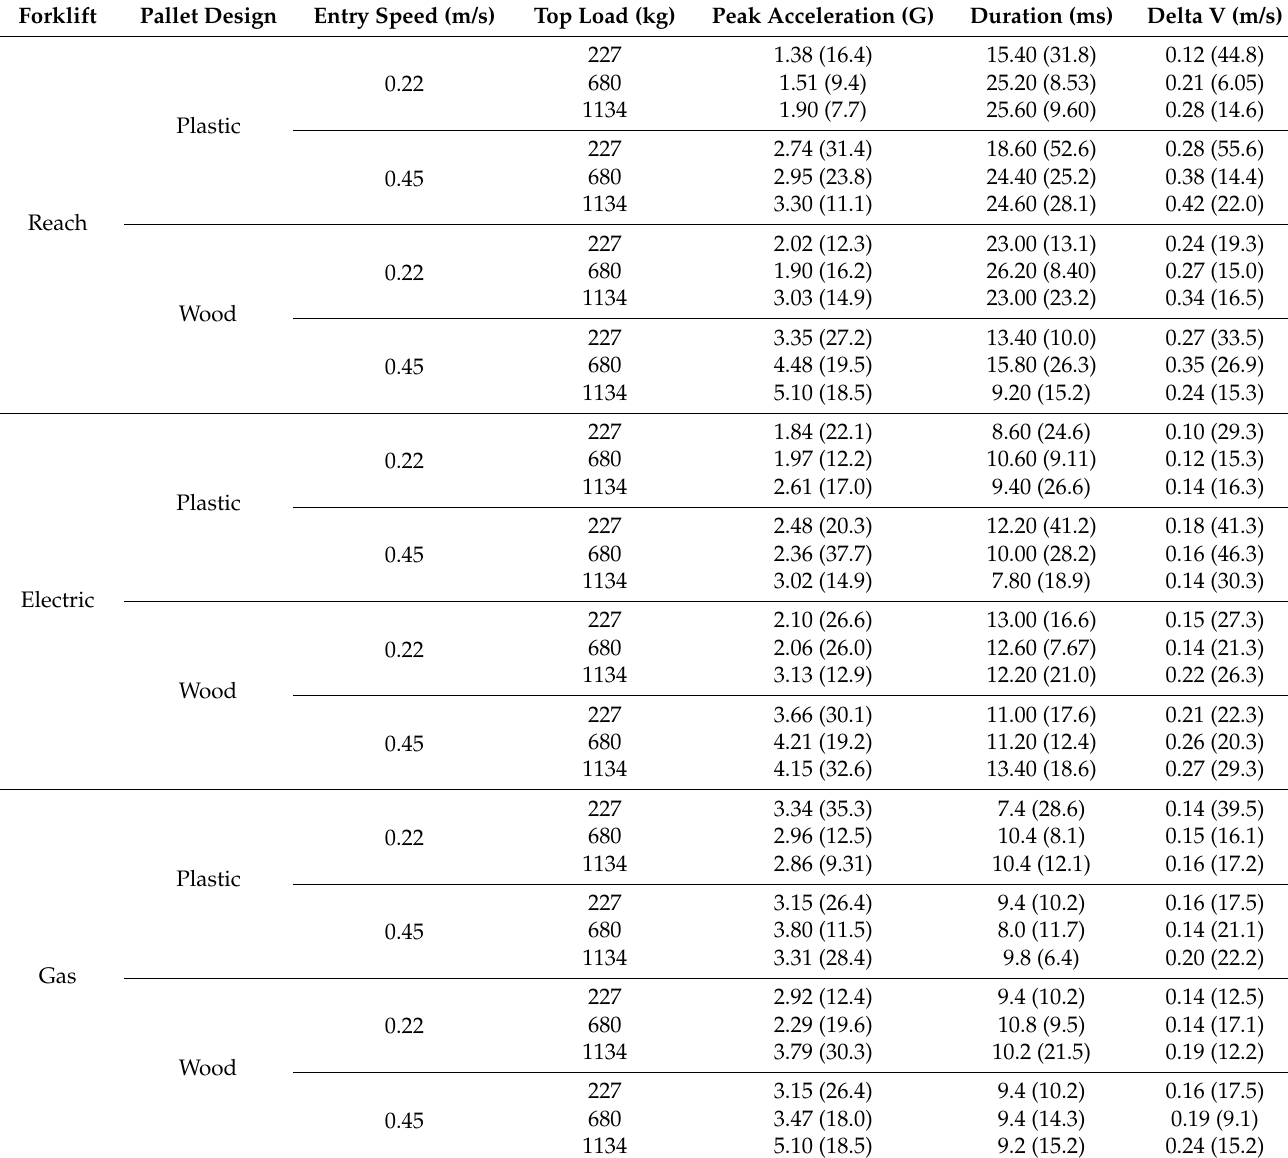
Table 4. Acceleration, duration, and Delta Velocity response at forklifts by factor configuration *.